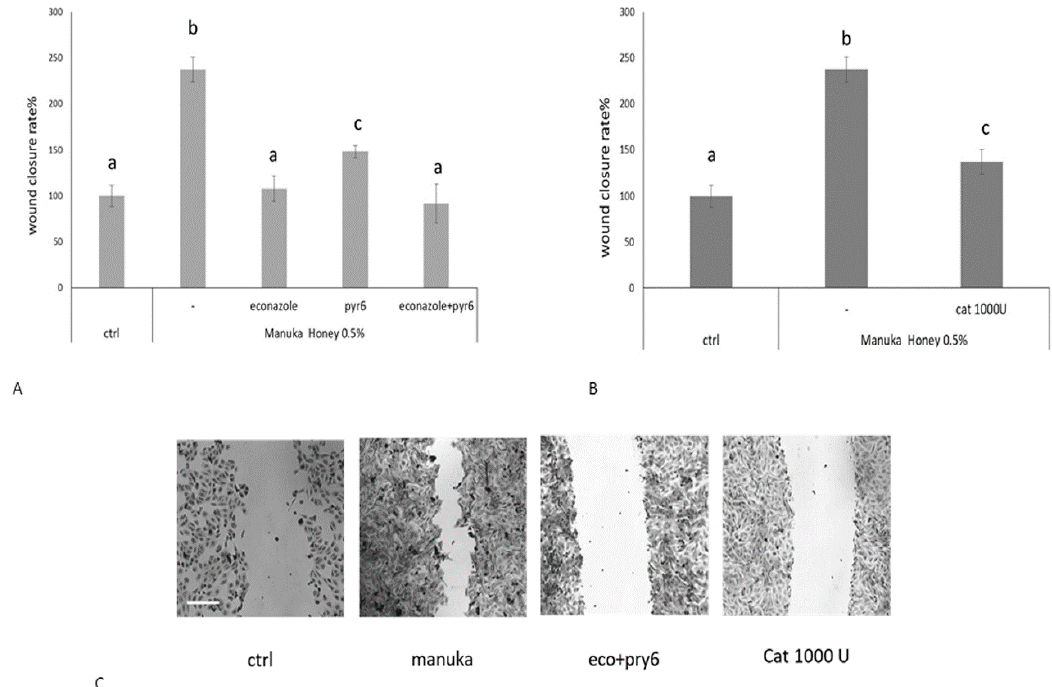
Figure 6. Manuka honey-induced wound closure requires hydrogen peroxide and extracellular Ca 2+ entry. ( A ) Effect of different inhibitors on honey-induced scratch wound repair of HaCaT monolayers. Each inhibitor was used according to the procedures, which were previously shown to inhibit manuka honey-induced extracellular Ca 2+ entry: 10 µM Econazole, 1 µM Pyr6. We also used ( B ) 1000 U CAT. Wound closure rate is expressed as the difference between wound width at 0 and 24 h. Data were recorded 24 h after scratch wound healing of cells exposed to 0.5% manuka honey, in the presence or absence of various inhibitors. Bars represent mean ± SEM of wound closure inhibition deriving from two independent experiments, each with n = 20. For each inhibitor, different letters above bars indicate significant differences according to Tukey’s test ( p < 0.01). ( C ) Micrographs of scratch wounded HaCaT monolayers incubated under control conditions or in the presence of manuka honey and inhibitors and then stained with blue toluidine and observed 24 h after wounding. Scale bar, 200 µm.